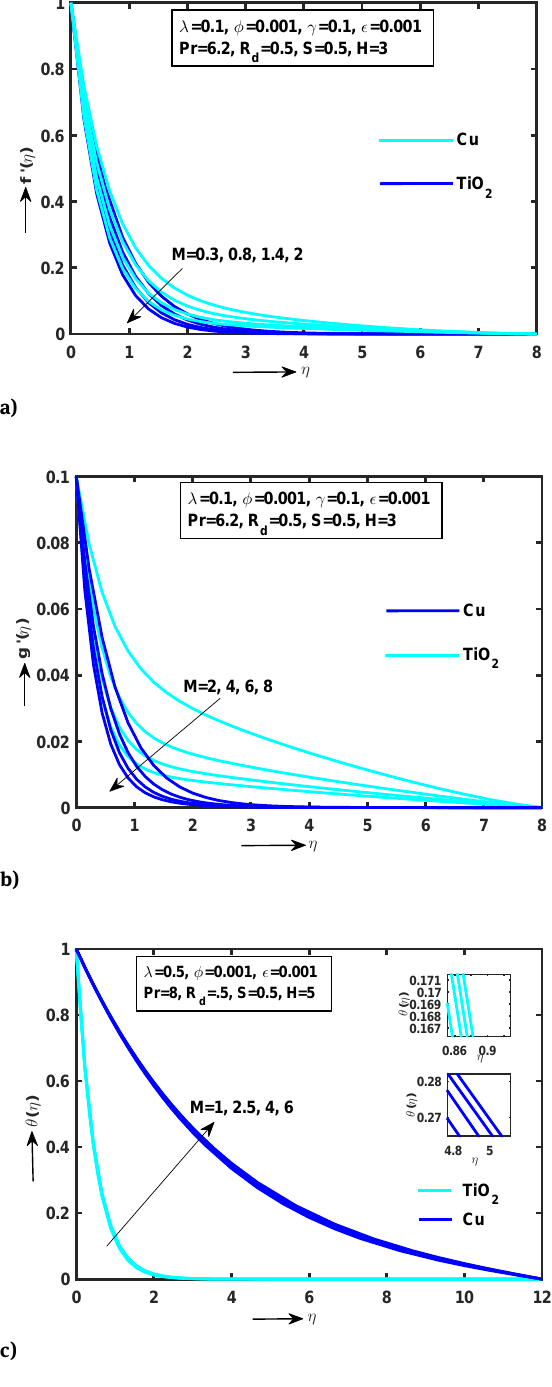
Figure 2: (a) Significance of M on f (cid:48) ( η ) (b) Significance of M on g (cid:48) ( η ) (c) Significance of M on θ ( η